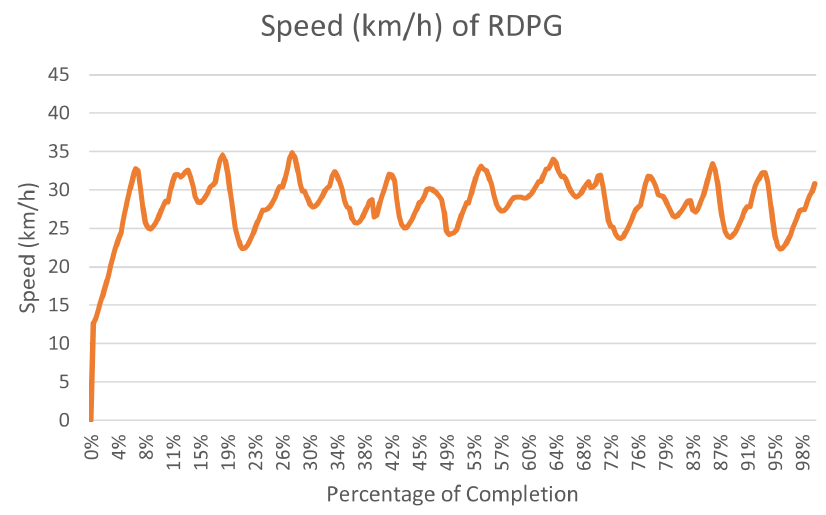
Figure 19. The speed data of the